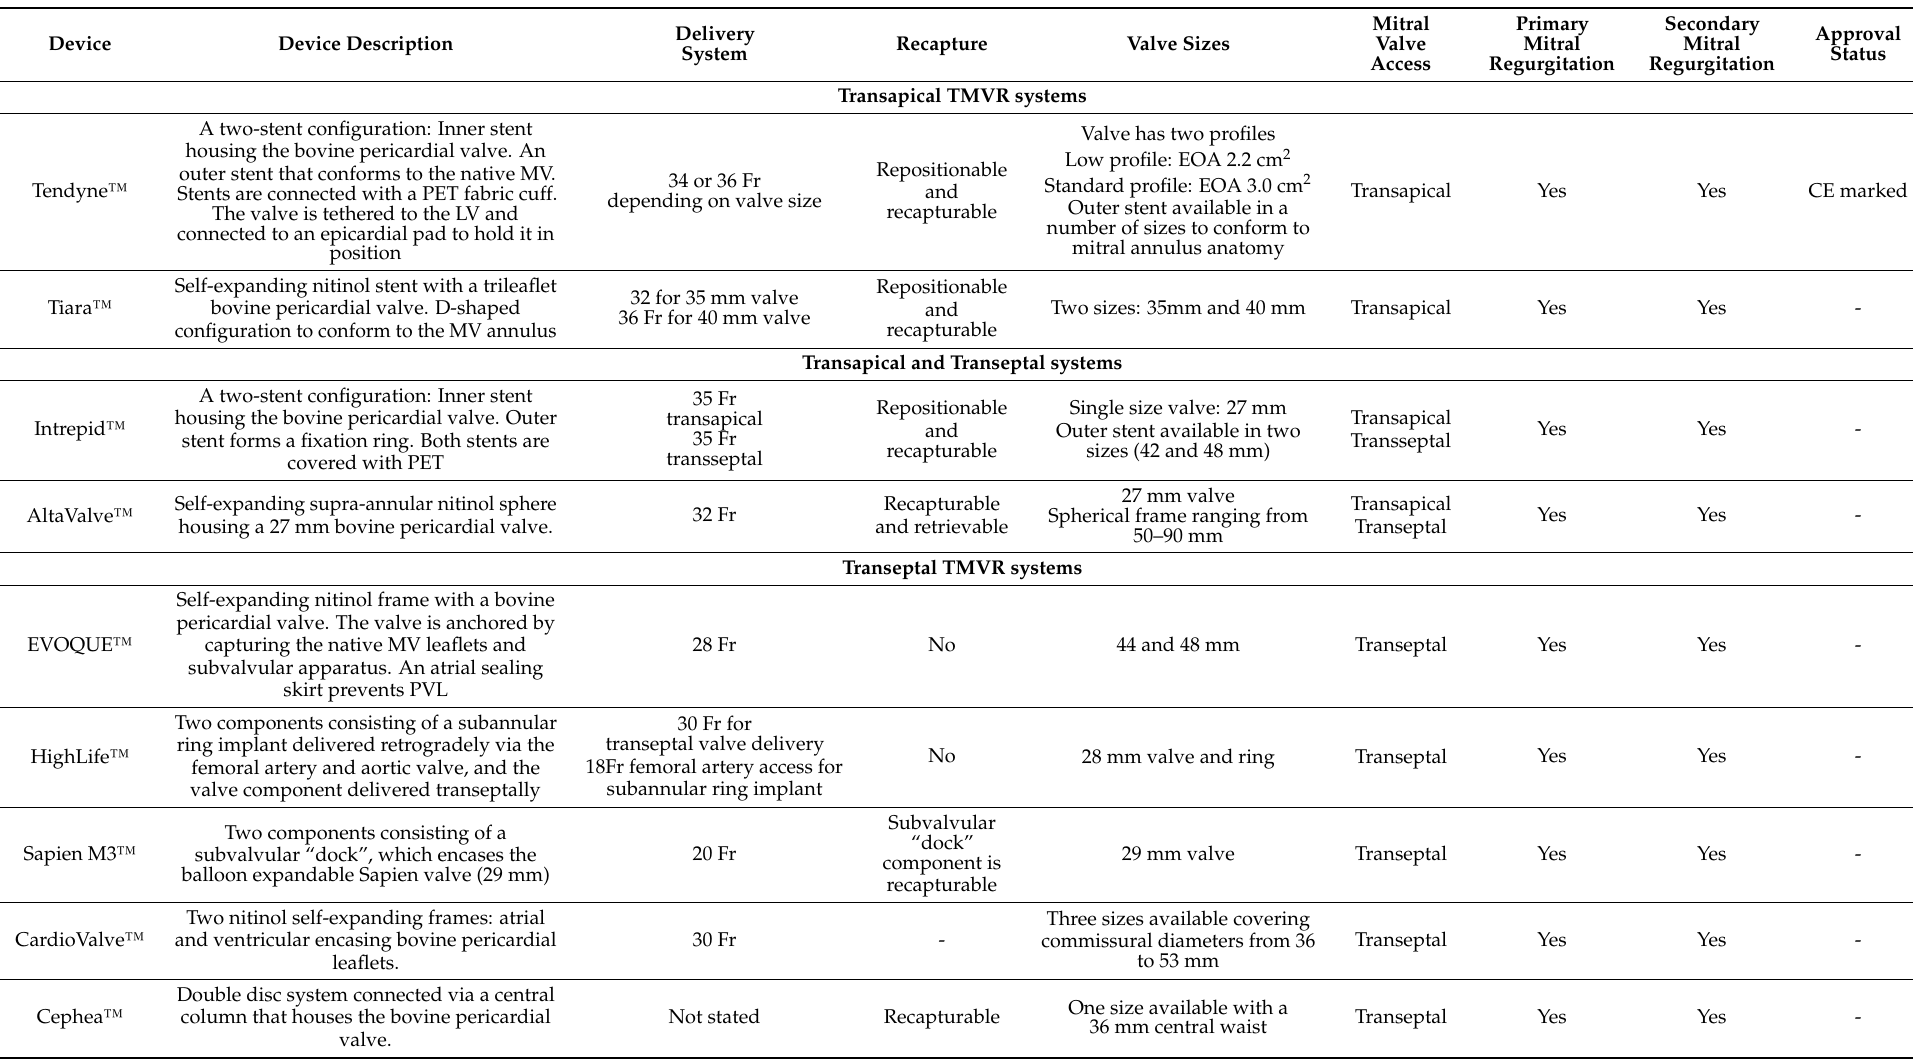
Table 4. Mitral valve replacement